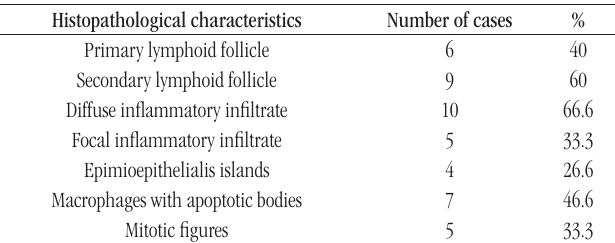
TABLE 3 – Histopathological characteristics of the 15 cases of oral lymphoid hyperplasia